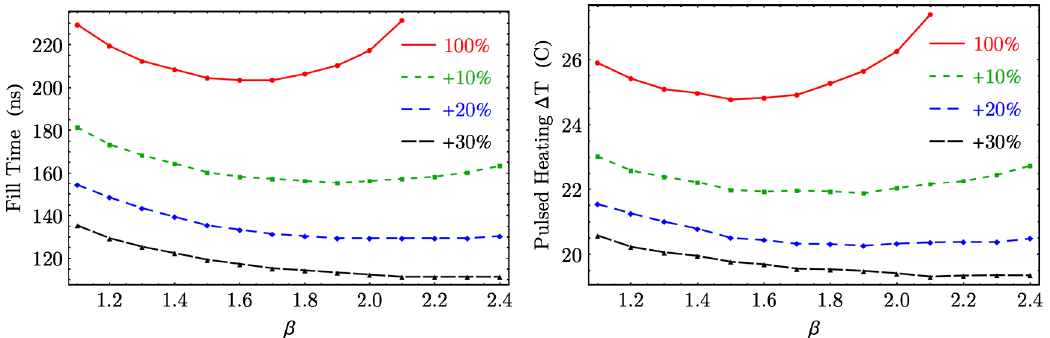
FIG. 3. Mark 1 X -band rf gun (cid:3) for fill time to reach 200 MV = m cathode field, and the corresponding pulsed heating temperature rise. Curves are shown for the nominal input power (100%) and 10%, 20%, and 30% additional power.